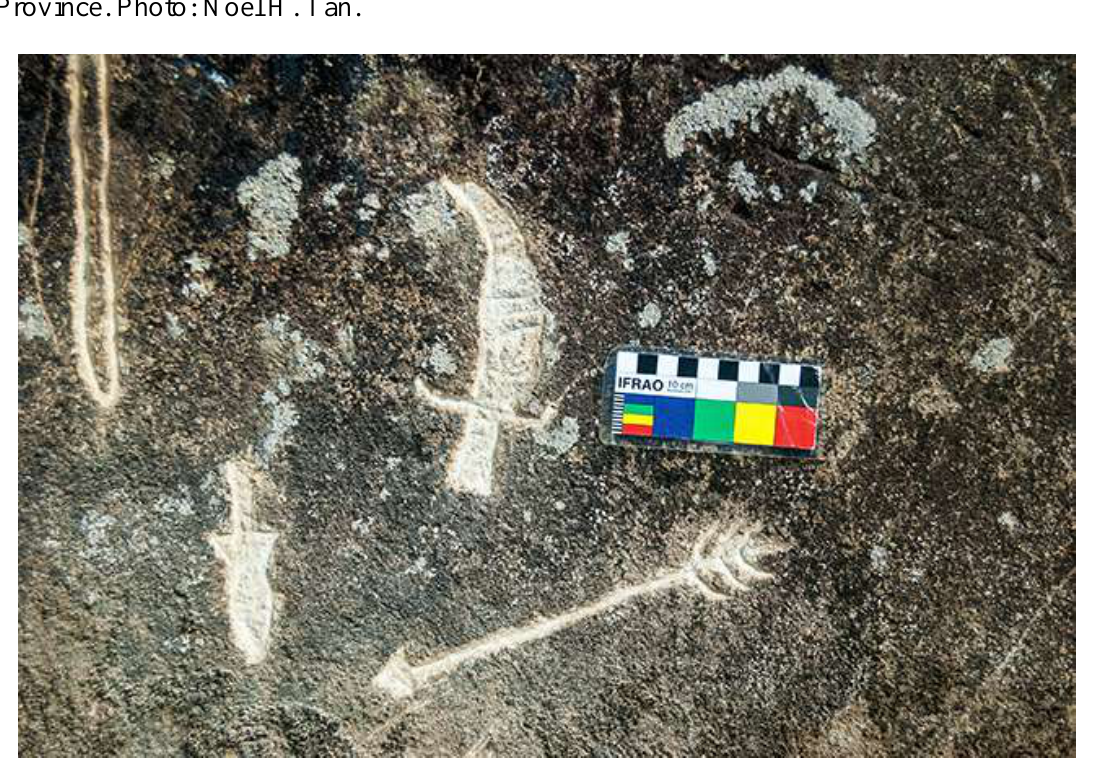
Figure 7. One of the engraved boulders from the Sa Pa Engraved Rock Field in Lao Cai Province. Photo: Noel H.